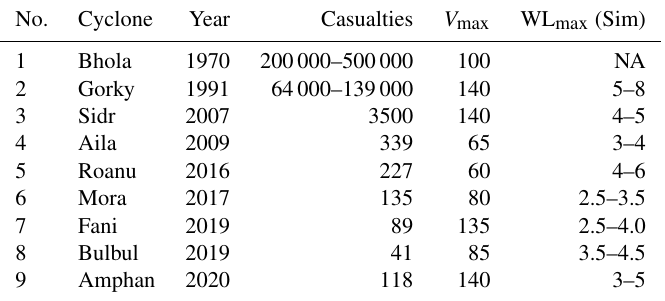
Figure 3. (a) Maximum simulated water level during cyclone Sidr. Comparison of simulated and observed water level during cyclone Sidr at (b) Charchanga, (c) Cox’s Bazar, (d) Hiron Point, and (e) Khepupara. The station locations are shown in (a) . Table 1. Simulated maximum water level for the cyclones shown in Fig. 1. V max is the maximum wind speed in knots, and WL max (Sim) is the simulated maximum water level range over the delta shoreline in metres. NA signifies not available. No. Cyclone Year